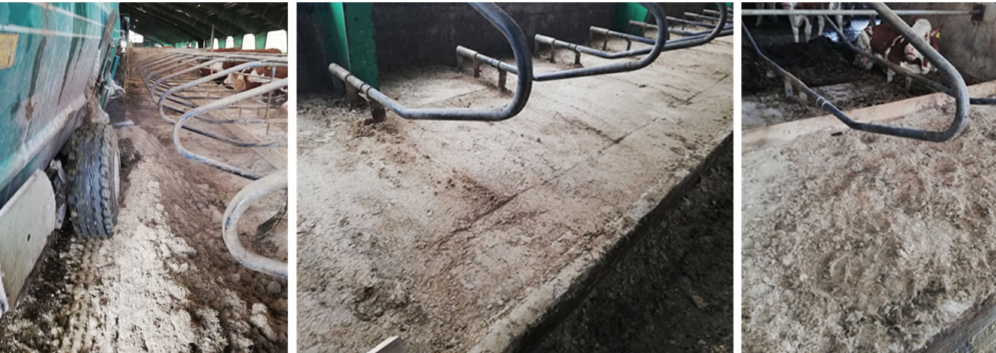
Figure 5. Production of bedding with improved composition for cows. Photo by Zigo F. (2019).